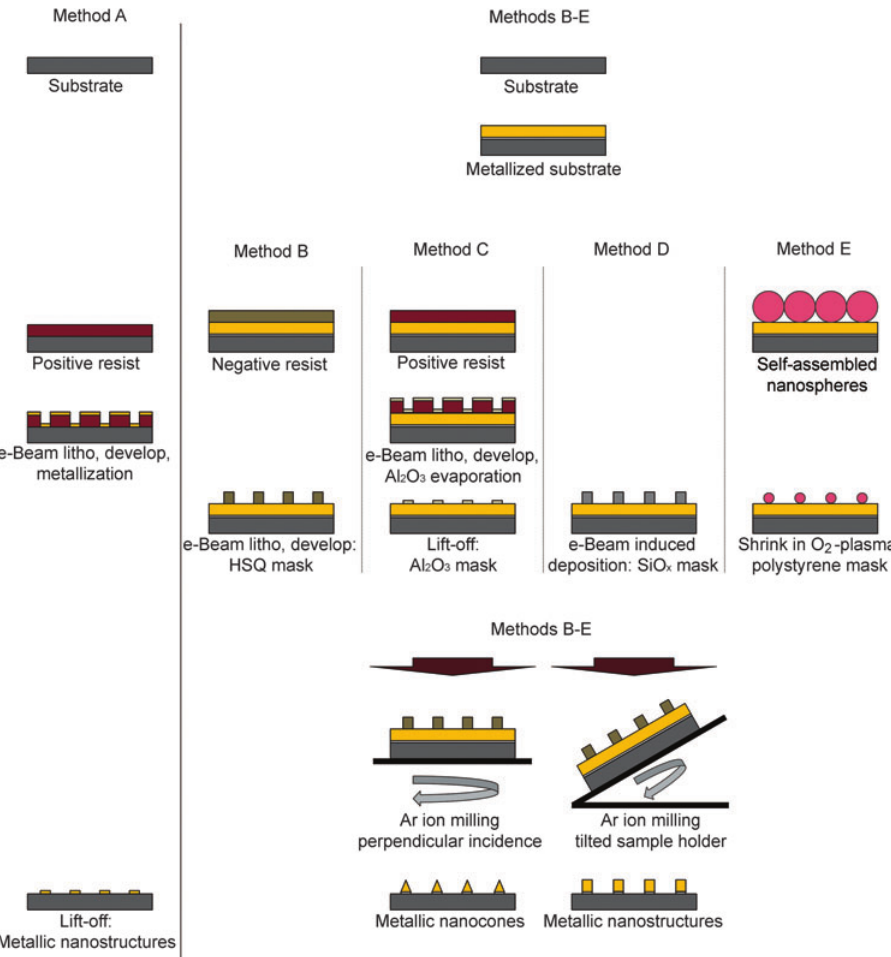
Figure 21 Strategies pursued for the fabrication of plasmonic nanostructures. Method A, standard liftoff process; method B, electron beam lithography of negative resist on a metal layer and subsequent argon ion milling; original process for nanocone fabrication; method C, electron beam lithography of positive resist on a metal layer, deposition of a transparent Al D, focused EBID of etch masks on a metal layer and subsequent argon ion milling; process suitable for nonplanar surfaces; method E, self- assembled monolayer of polystyrene beads with subsequent shrinking of the beads and argon ion milling; fully parallel process for larger area coverage. Figure by M.